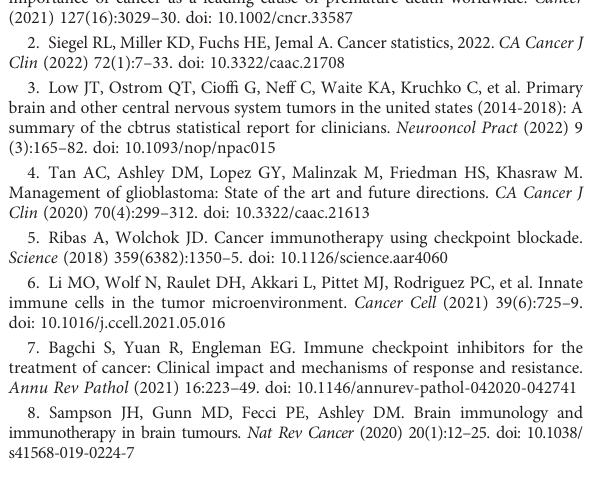
SUPPLEMENTARY FIGURE 2 The correlation analysis between ASB3 expression and clinical features of GBM. (A) IDH mutation status. (B) Subtypes of GBM. (C) Radiotherapy status. (D) MGMT promoter methylation status. (E) Chemotherapy status. (F) Age. SUPPLEMENTARY FIGURE 3 The correlation of ASB3 expression and immune cell in fi ltration. (A) Correlation heatmap between ASB3 and immune cell in fi ltration in pan-cancer. (B) Spearman correlation test of ASB3 expression and TEM in GBM. (C) Spearman correlation test of ASB3 expression and Tregs in GBM. SUPPLEMENTARY FIGURE 4 The correlation of ASB3 expression and immunosuppressors. (A) Correlation heatmap between ASB3 and immunosuppressors in pan-cancer. (B) Spearman correlation test of ASB3 expression and TGFB1 in GBM. (C) Spearman correlation test of ASB3 expression and PD-1 in GBM. SUPPLEMENTARY FIGURE 5 Enrichment plots from GSEA GO (Independent cohort). (A) B Cell Mediated Immunity. (B) Cytokine Activity. (C) Immunoglobulin Receptor Binding. (D) Humoral Immune Response Mediated by Circulating Immunoglobulin. (E) Antigen Binding. (F) Complement Activation. SUPPLEMENTARY FIGURE 6 Enrichment plots from GSEA KEGG (Independent cohort). (A) Toll Like Receptor Signaling Pathway. (B) Lysosome. (C) Chemokine Signaling Pathway. (D) Cytokine-Cytokine Receptor Interaction. (E) Cell Adhesion Molecules CAMS. (F) Primary Immunode fi ciency. SUPPLEMENTARY FIGURE 7 Correlation of ASB3 expression and immunotherapy response in human renal cell